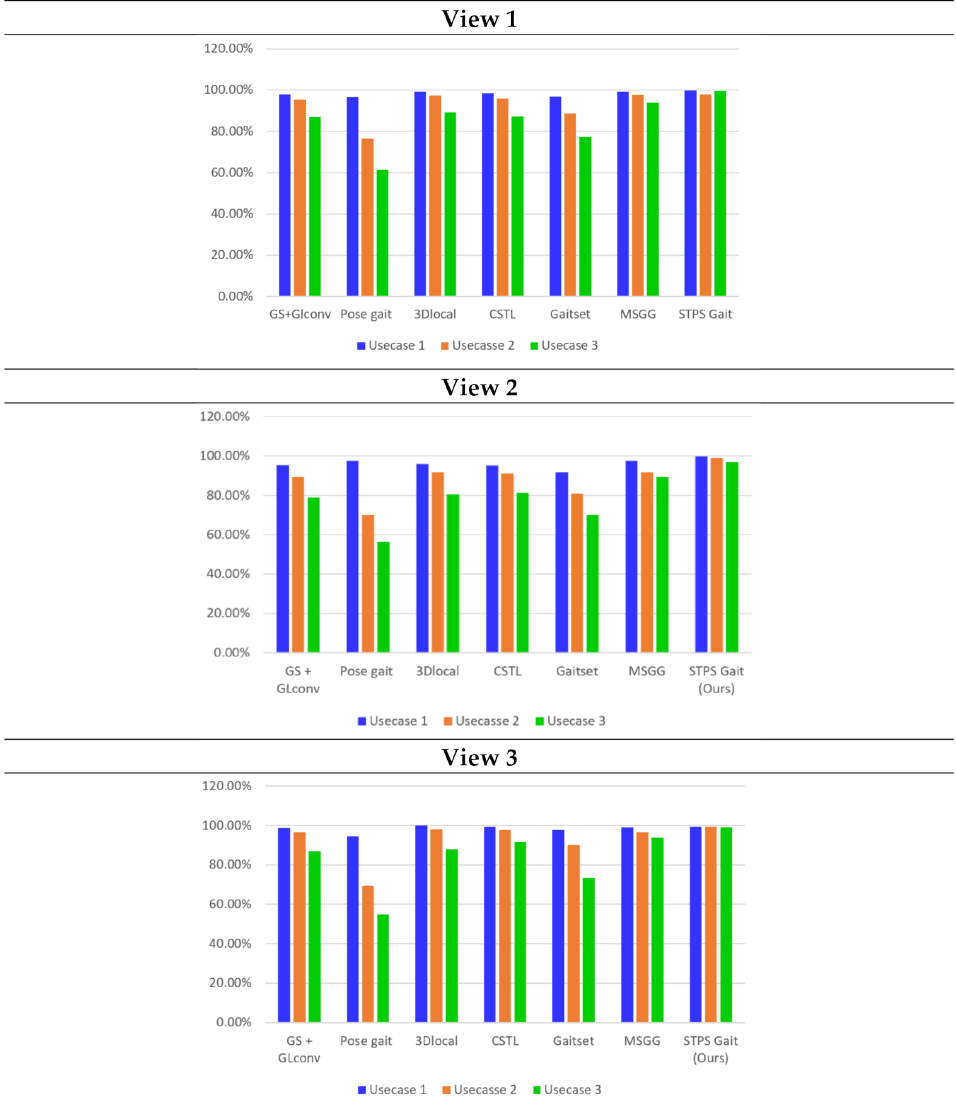
Figure 8. Comparison of STPS with Existing Work for Views 1–3 and Use Cases